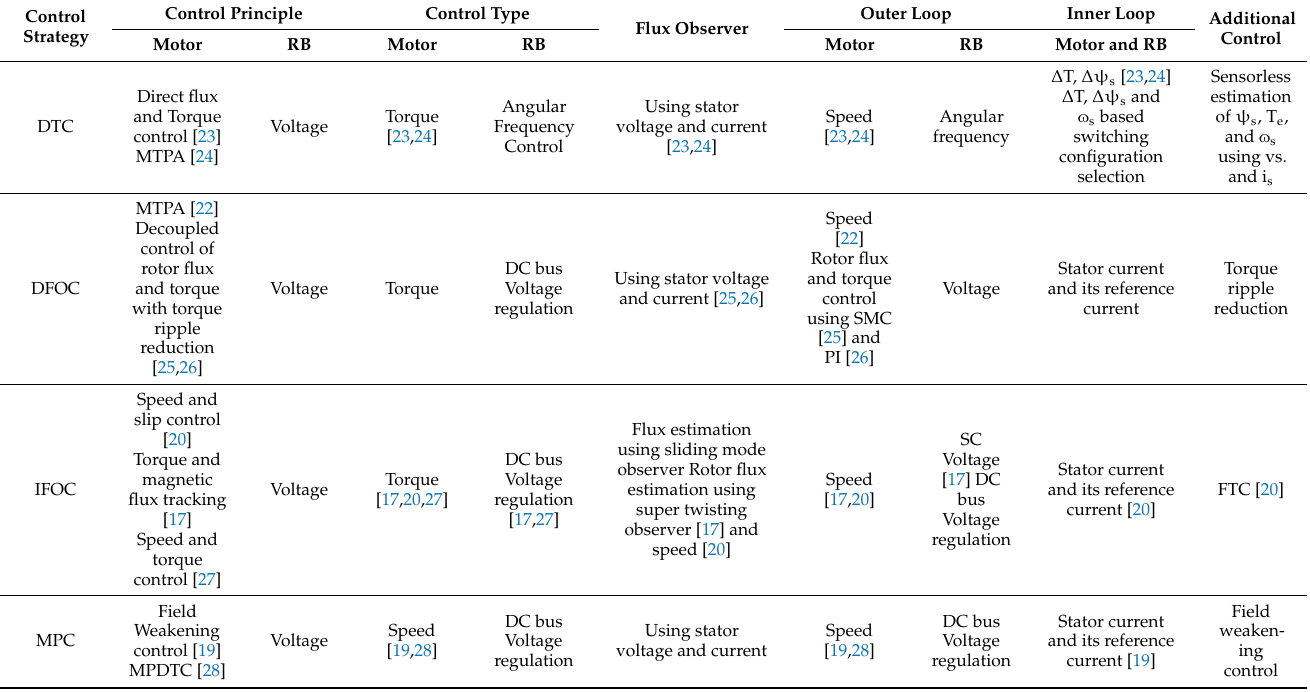
Table 1. Control strategies used in